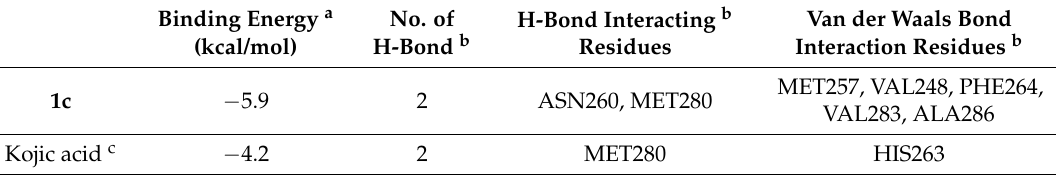
Figure 3. Docking simulation of compound 1c and kojic acid with tyrosinase and pharmacophore analysis. Docking simulation results between compound 1c and kojic acid toward mushroom tyrosinase ( A ). Pharmacophore results for 1c ( B ) and kojic acid ( C ) obtained using LigandScout 3.1.2 showing hydrogen-bonding (green arrow), π - π stacking (violet arrow) and hydrophobic (yellow) interactions. Table 3. Tyrosinase inhibitory activity of 1c.